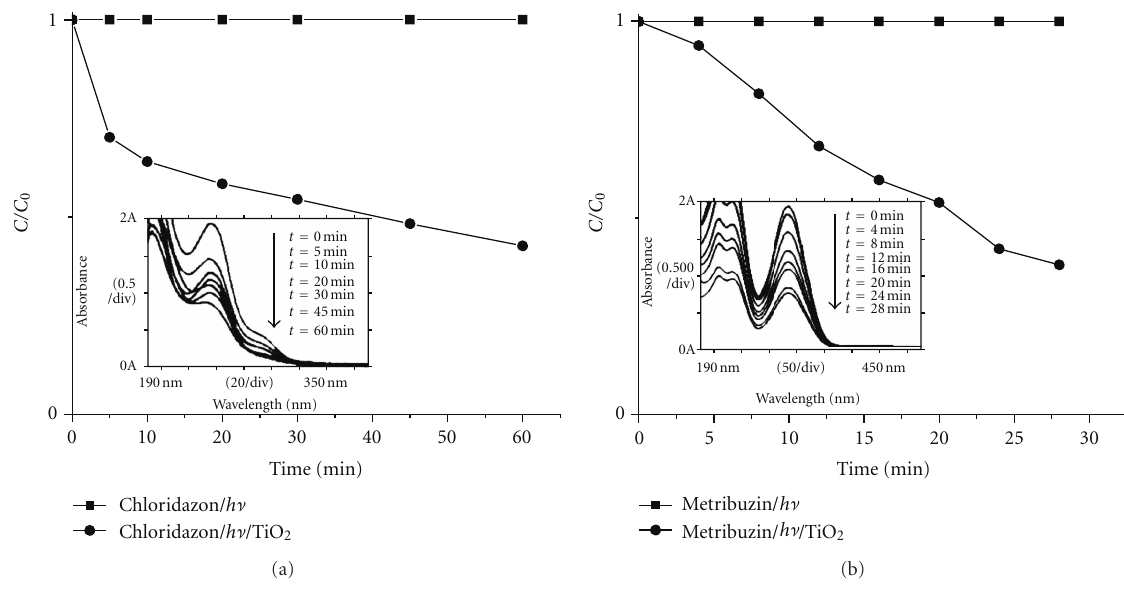
Figure 1: (a) Change in concentration as a function of time on irradiation of an aqueous solution of CHL in the presence and absence of photocatalyst. Inset: Change in absorption intensity at 238 nm on irradiation of aqueous suspension of CHL containing TiO 2 . Experimental conditions : CHL (0.18mM), V = 125 mL, 125 W medium pressure mercury lamp, light intensity: 4.88 mW/cm 2 , irradiation time: 60 min. (b) Change in concentration as a function of time on irradiation of an aqueous suspension of MET in the presence and absence of photocatalyst. Inset: Change in absorption intensity at 295 nm on irradiation of aqueous suspension of MET containing TiO 2 . Experimental conditions: MET (0.30 mM), V = 125 mL, 125 W medium pressure mercury lamp, light intensity: 4.88 mW/cm 2 , Irradiation time: 28